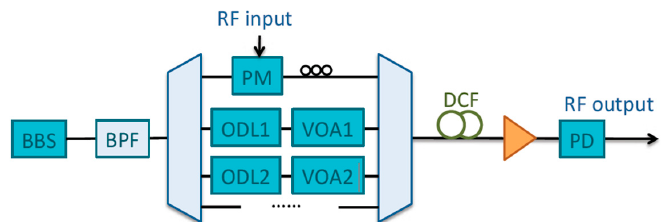
Figure 3. Schematic diagram of the microwave photonic filter with independently tunable passbands (with the courtesy of Dr. Y. Jiang). BBS: broadband optical source, BPF: optical filter, ODL(1,2): optical delay line, VOA(1,2): variable optical attenuator, PM: phase modulator, DCF: dispersion compensating fiber, PD: photodetector.